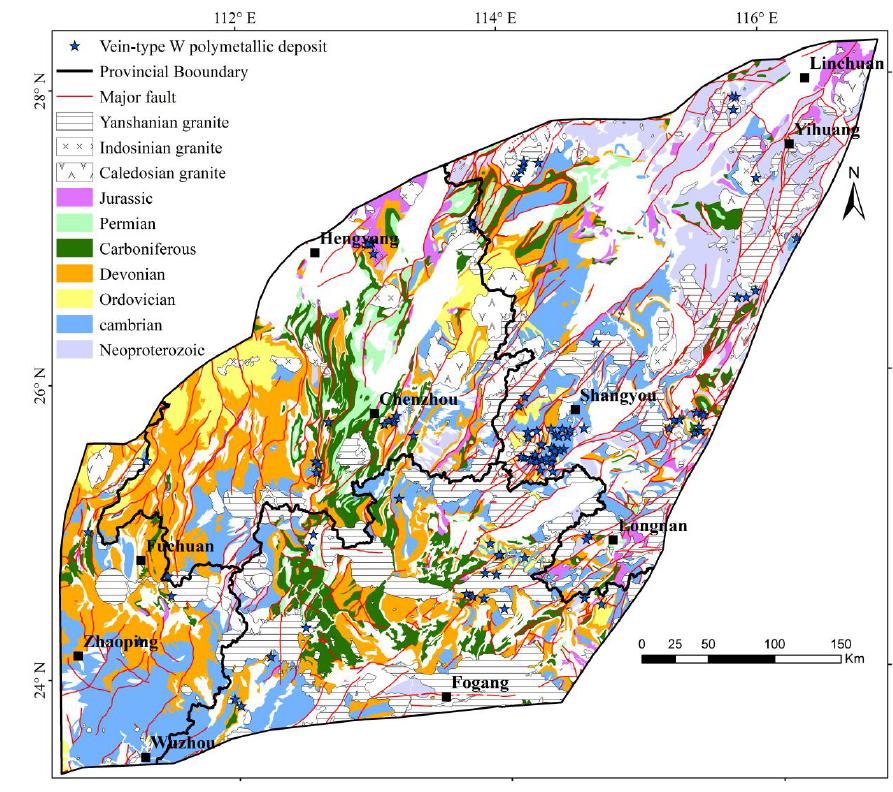
Fig. 1. Geological map of the study area modified from existing 1:2500000scale geological map (CGS, 2011).